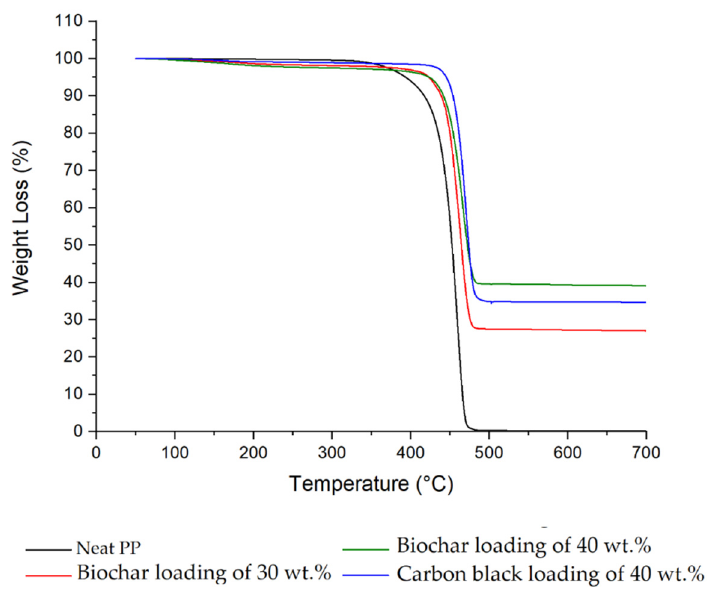
Figure 4. Thermal stability of di ff erent composites: neat polypropylene (PP), biochar (30 and 40 wt%), and carbon black (40 wt%). The thermogravimetric analysis (TGA) data summary of biochar and carbon black containing